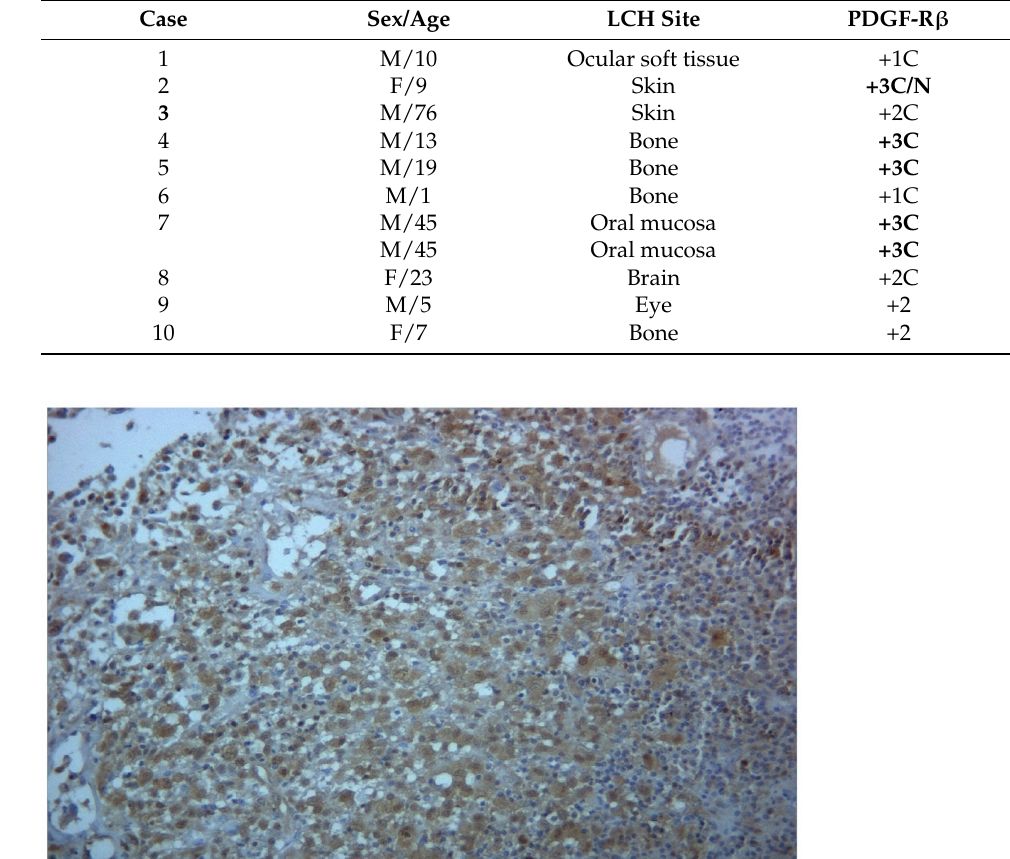
Table 1. Immunohistochemical evaluation of PDGF-R β in 10 patients. Strong expression of PDGFR β was outlined by bold character. C: cytoplasmic; N: nuclear.